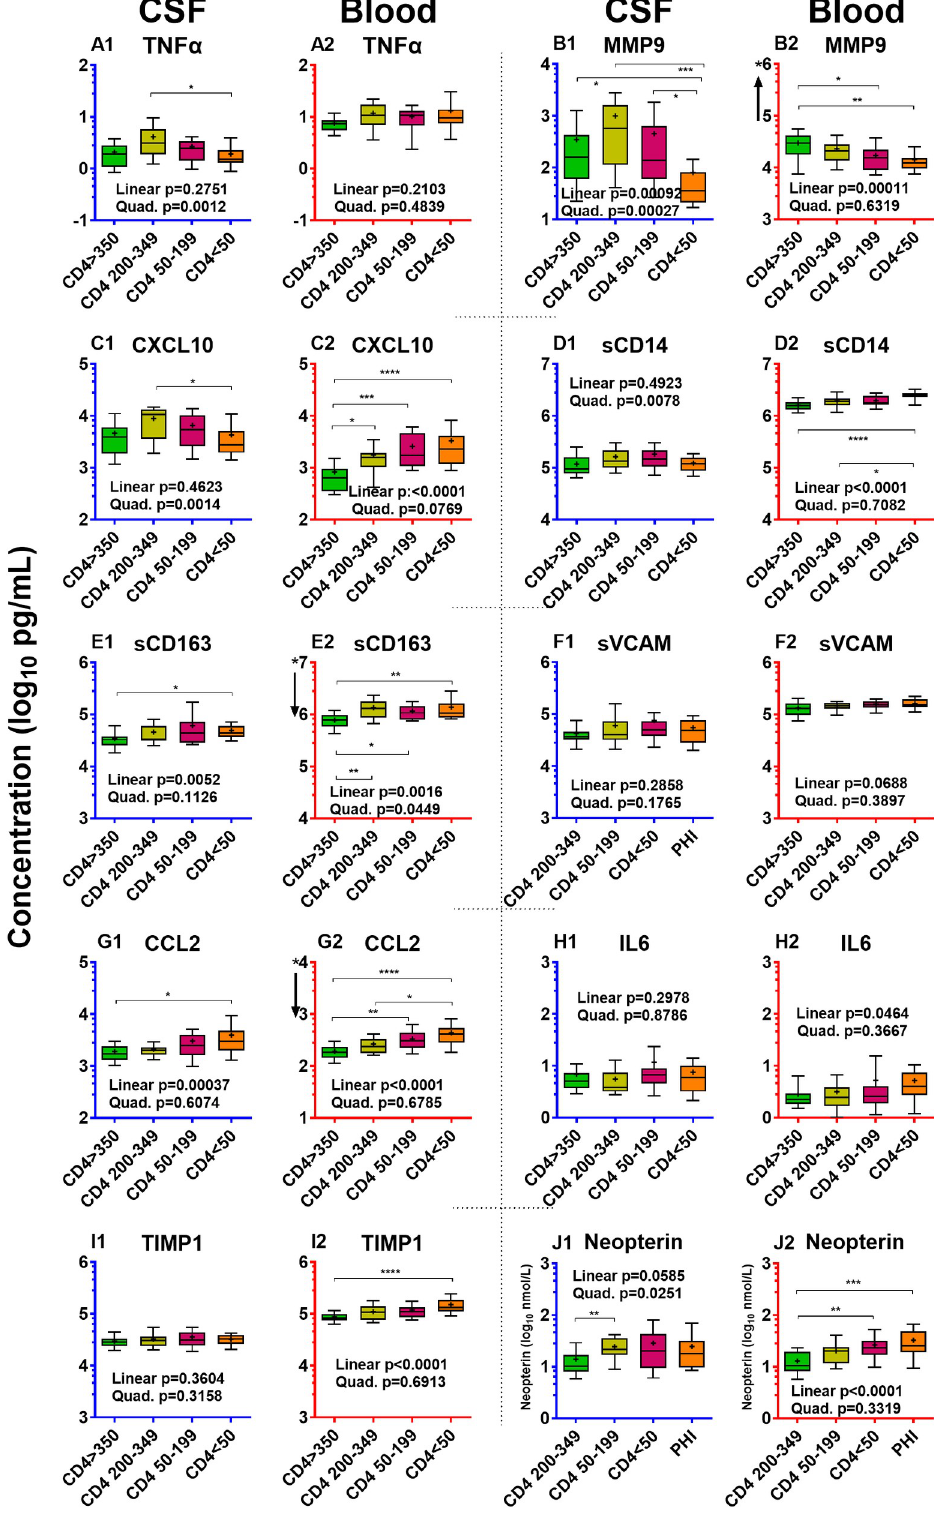
Fig 4. Inflammatory biomarkers in four CD4 + -defined groups of untreated without HAD. These graphs use the same format, axes and unit scales as Fig 1 but isolate the results comparing the four NA groups with progressive